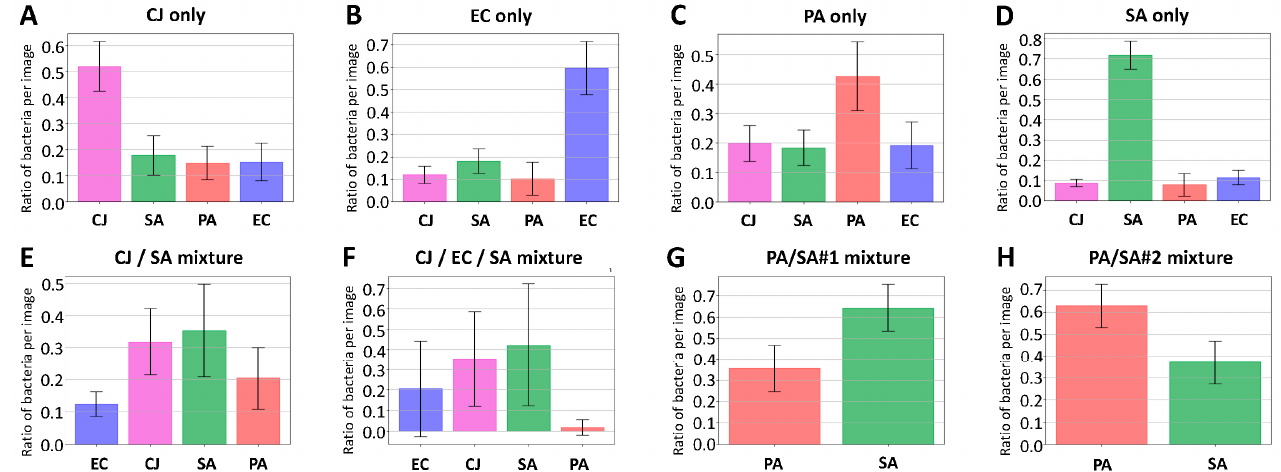
Figure 9. Analysis of mixture of bacteria. ( A – D ) correspond to pure solutions of C. jeikeium , E. coli , P. aeruginosa and S. aureus , ( E ) to a mixture of C. jeikeium and S. aureus, ( F ) to the same mixture with E. coli in addition and ( G , H ) to two mixtures of S. aureus and P. aeruginosa with different ratios (three times more P. aeruginosa in H). Images of all pictures have been analysed with RF and the 1-over-4 strategy, except for ( G , H ) that have been analysed with a RF P. aeruginosa / S. aureus classifier. Error bars correspond to the standard deviation of the ratio of bacteria measured over 15 images for each mixture. The average number of bacteria on each image is 30 ± 10 for ( A ), 150 ± 50 for ( B ), 150 ± 20 for ( C ), 120 ± 20 for ( D ), 25 ± 5 for ( E , F ), 60 + 20 for ( G , H ). Imaged bacteria are all in the stationary phase.